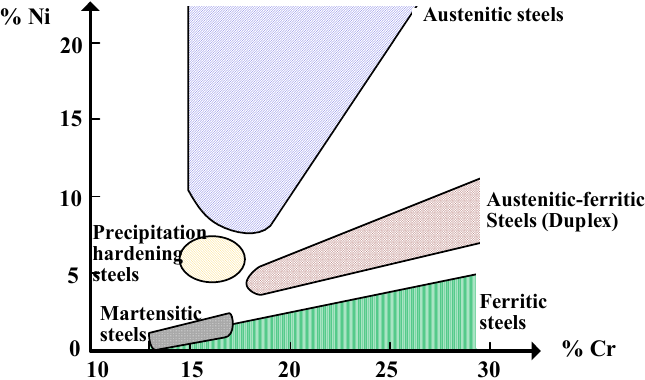
Figure 1. Classification of stainless steels groups based on the content of chromium (Cr) and nickel (Ni).